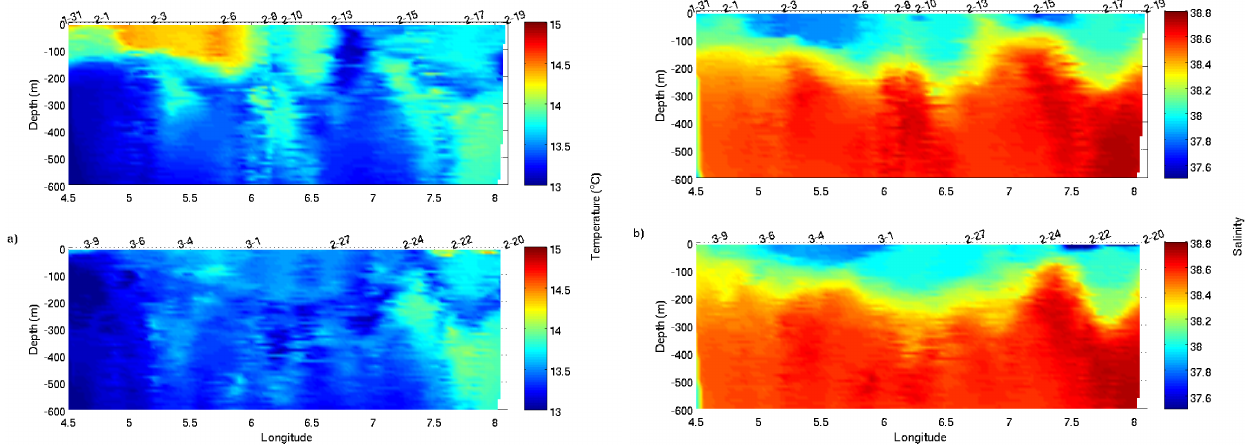
Figure 2. Zonal sections of (a) temperature and (b) salinity for the outbound (upper panels) and return (lower panels) legs of the glider Fig. 2. Zonal sections of a) Temperature and b) Salinity for the outbound (upper panels) and return mission. (lower panels) legs of the glider mission.